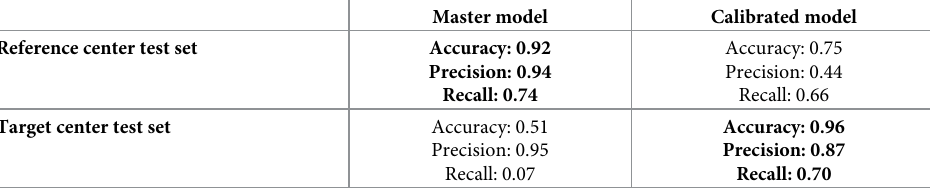
Table 3. Comparison of master model and calibrated model performance.